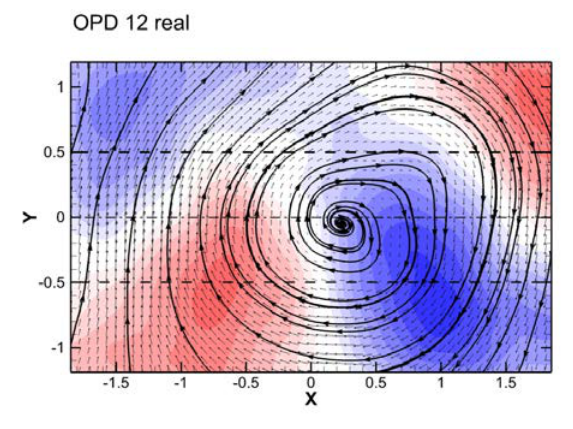
Fig. 6. Real part of the OPD mode 14 topology .